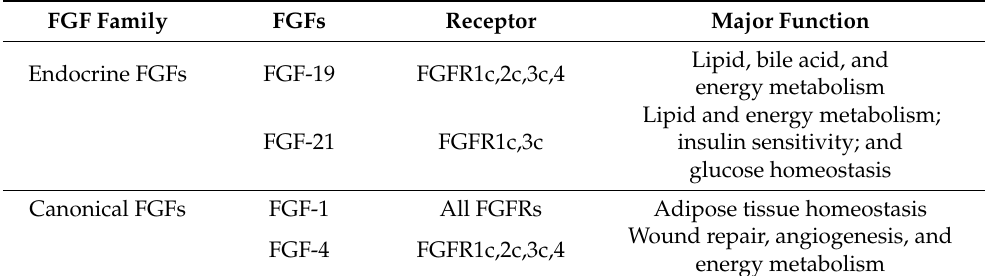
FGFs: fibroblast growth factors; FGFR: fibroblast growth factor